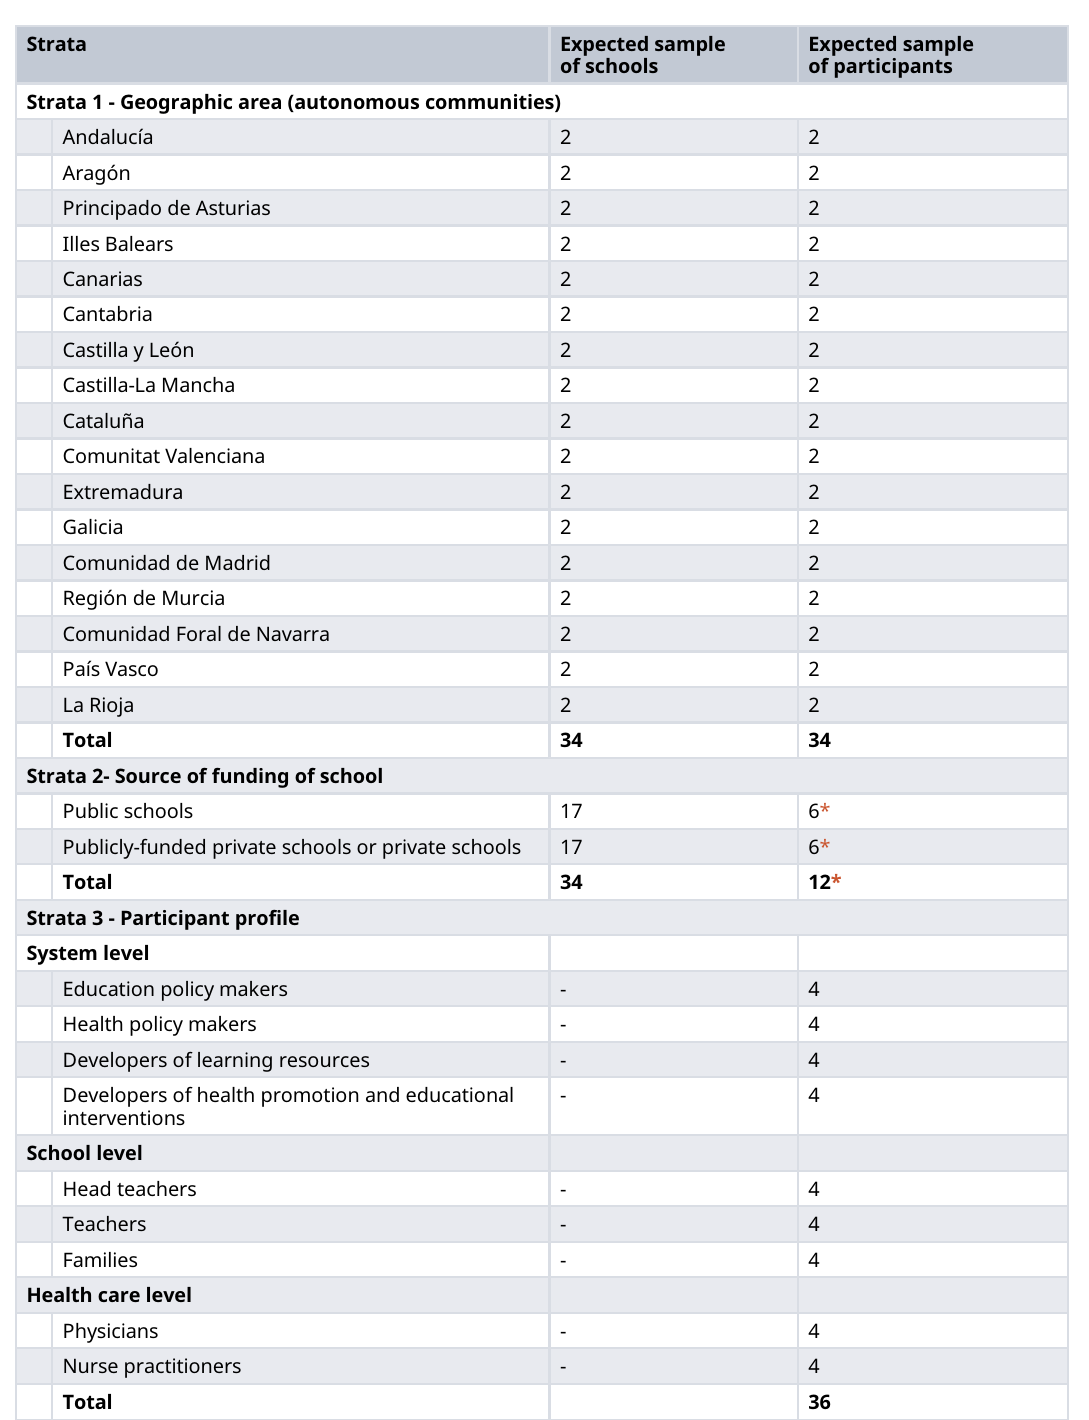
Table 3. Stratified sampling strategy. Strata Expected sample